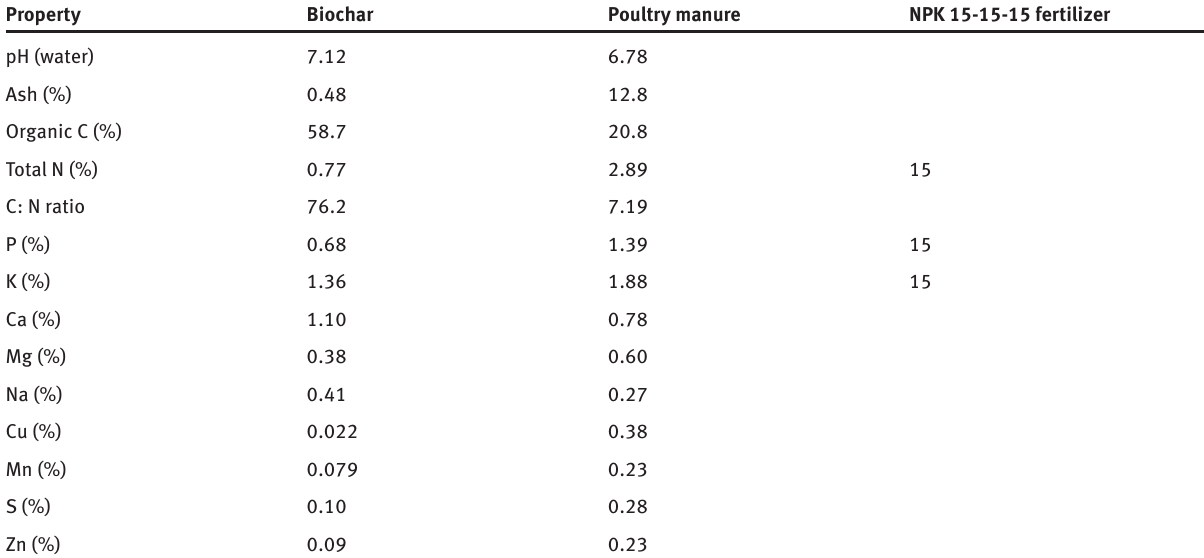
Table 2: Chemical analysis of biochar, poultry manure and NPK fertilizer used Property